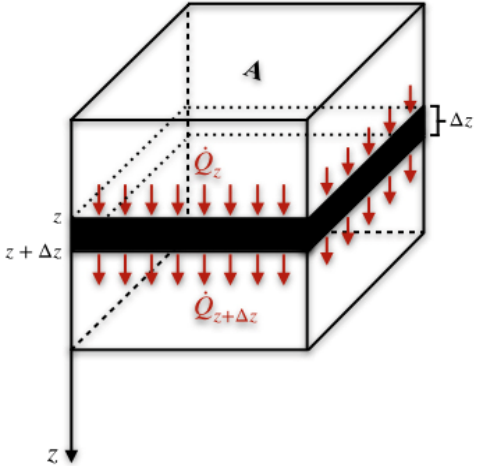
Figure 1. Volume element contained in a soil layer.